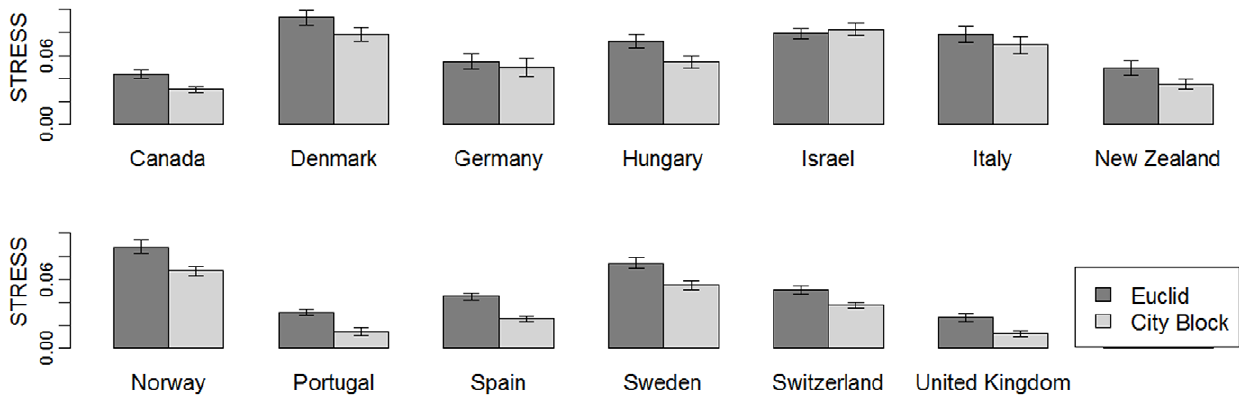
Figure 3. Mean ( ± SE) stress for each country in Euclidean and city-block metrics.